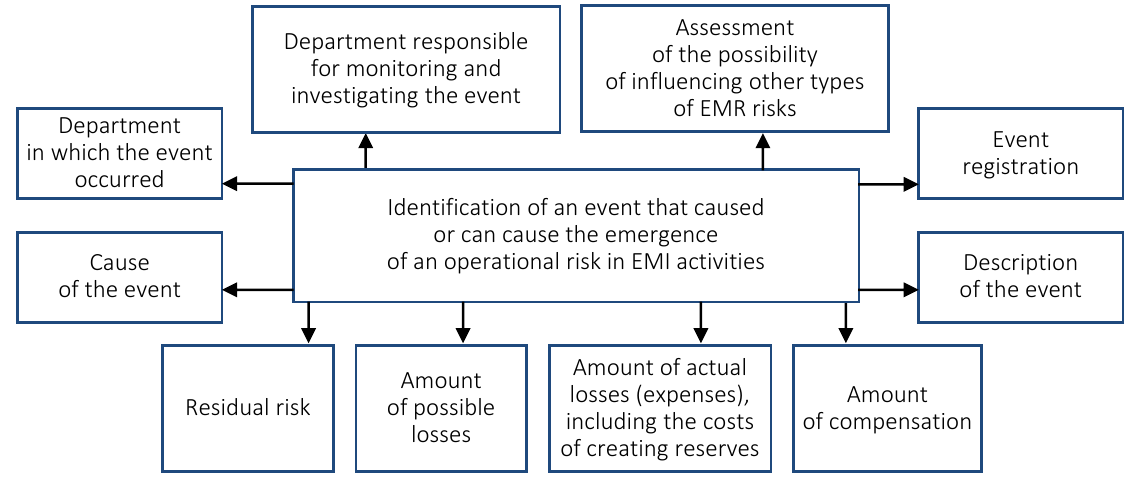
Figure 2. Scheme for organizing the identification and documentation of events that have resulted in operational